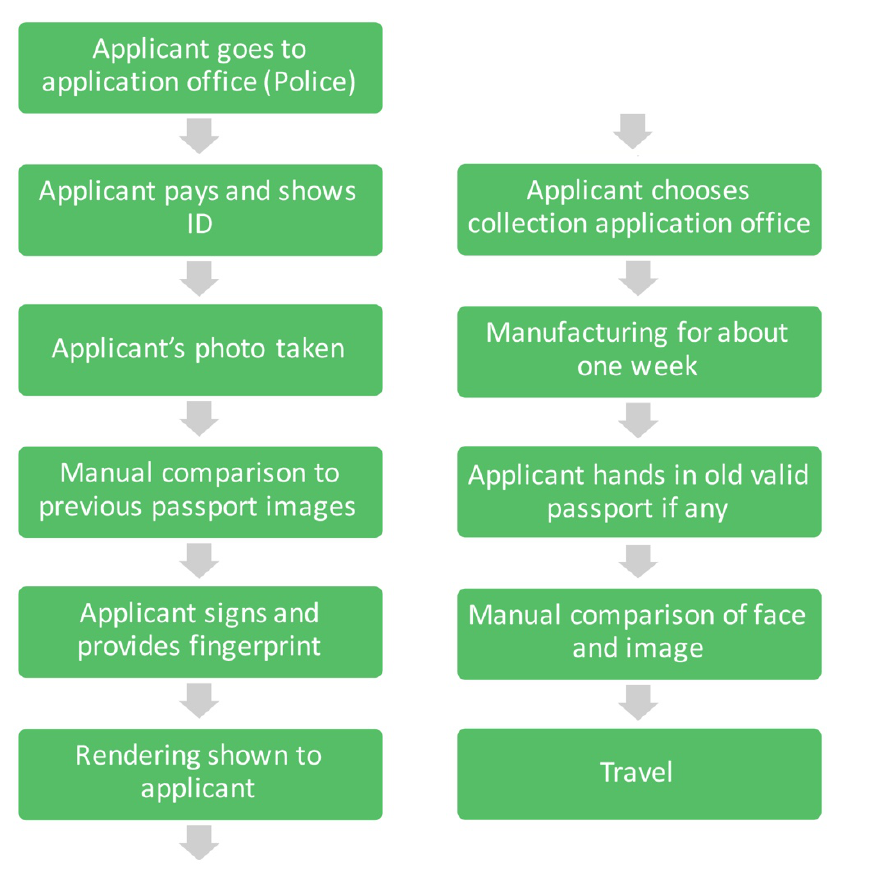
Figure 2: Application for passport and delivery in